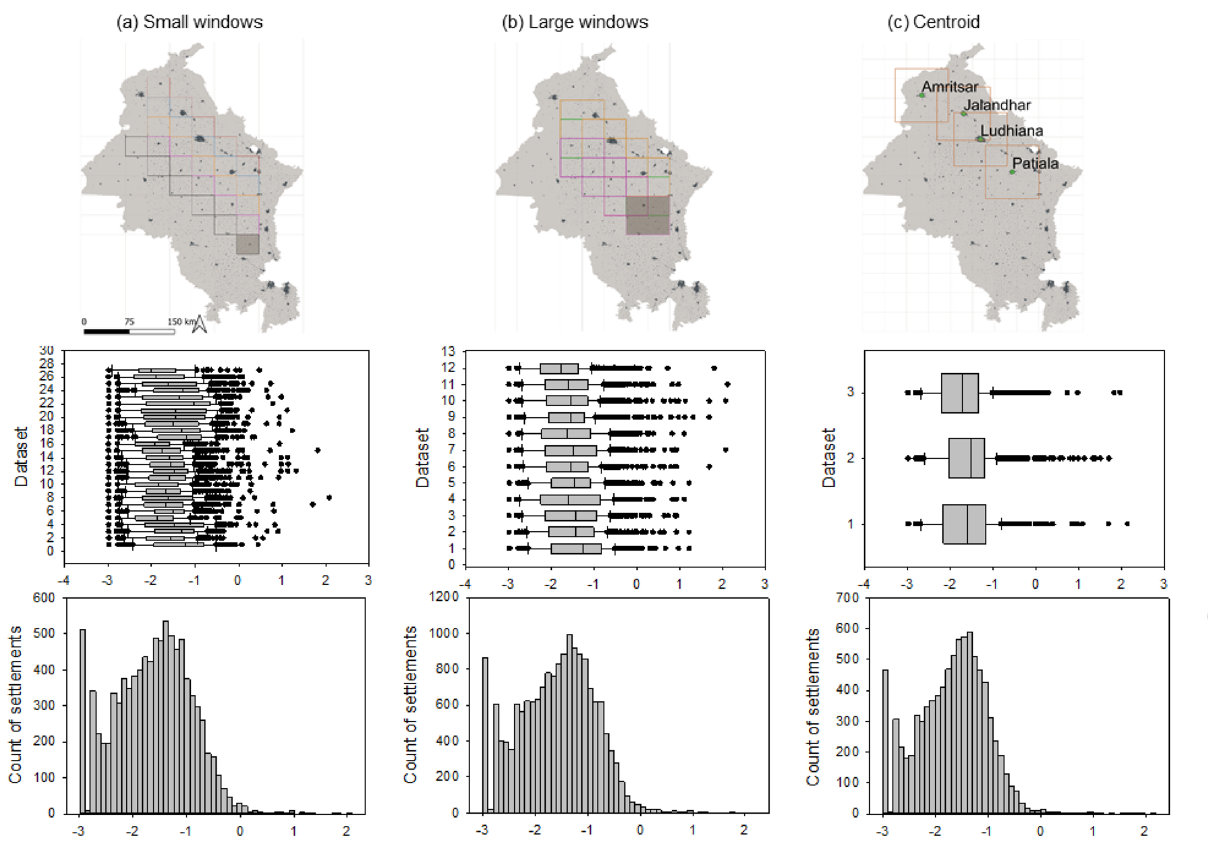
Figure 3. Settlement size distribution in the N-Indian Punjab. Maps, box plots and histograms of sampling used the moving window approach with ( a ) small and ( b ) large windows, and ( c ) the centroid approach. The small window generated 27 datasets, the large window 12 datasets, and the centroid sampling generated three datasets surrounding the mega settlements of Ludhiana, Patiala, and Jalandhar (Settlement binary map of 2016). The histograms aggregate the data shown in the box plots for each sampling